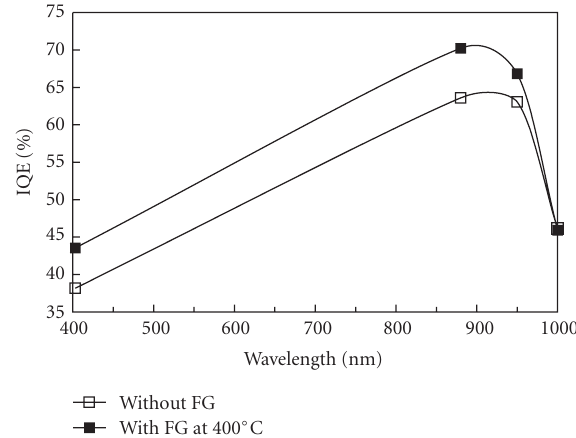
Figure 7: Improved internal quantum e ffi ciency (IQE) of the mc-Si solar cells with/without by H 2 FG